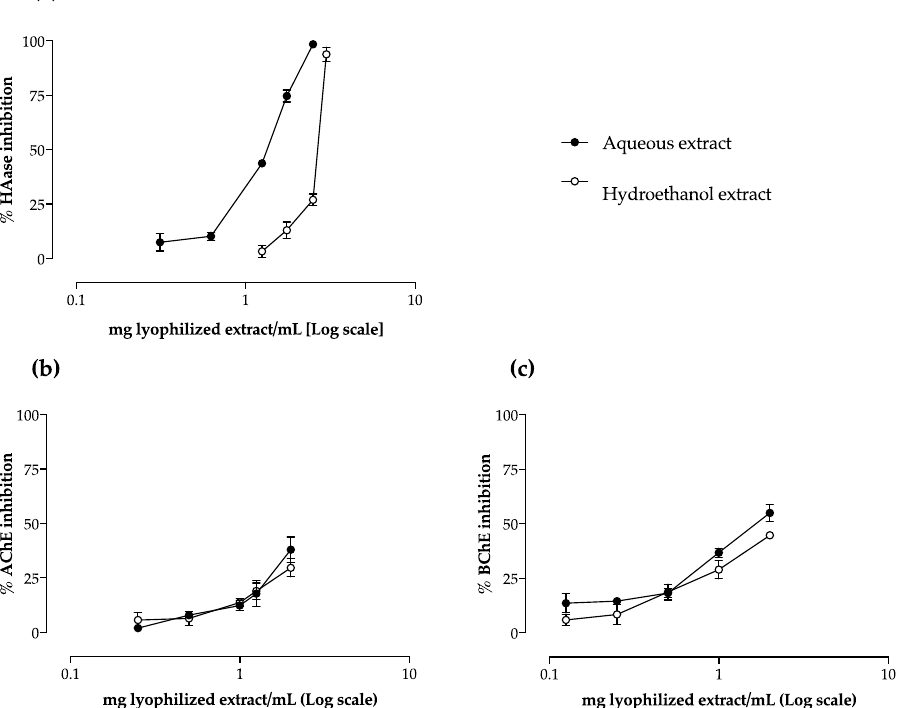
Figure 4. Effect of camel grass extracts on hyaluronidase (HAase) ( a ), acetylcholinesterase (AChE) ( b ), and butyrilcholinesterase (BChE) ( c ) activity. Results are expressed as percentage of control (mean ± SD of, at least, three determinations).